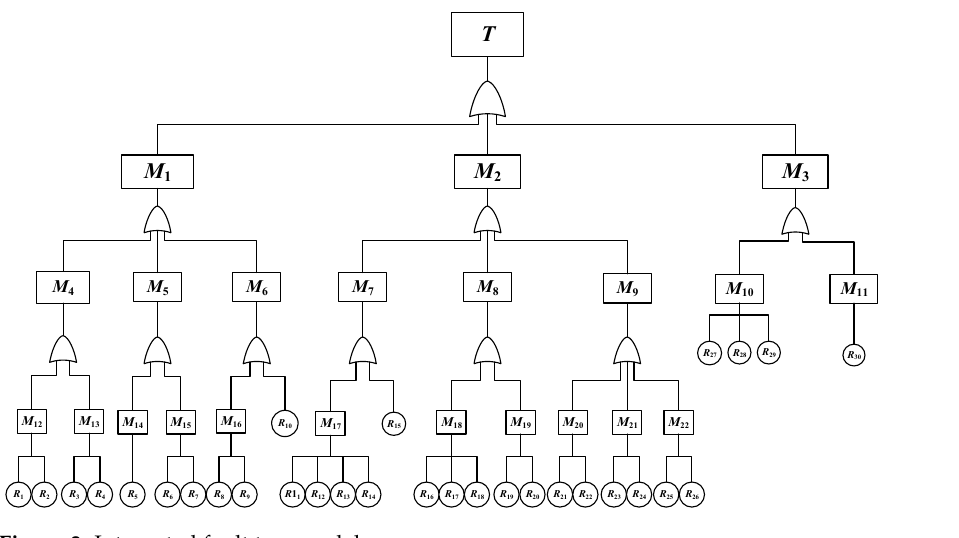
Figure 3. Integrated fault tree model. Table 1. Fault symbols and fault types.